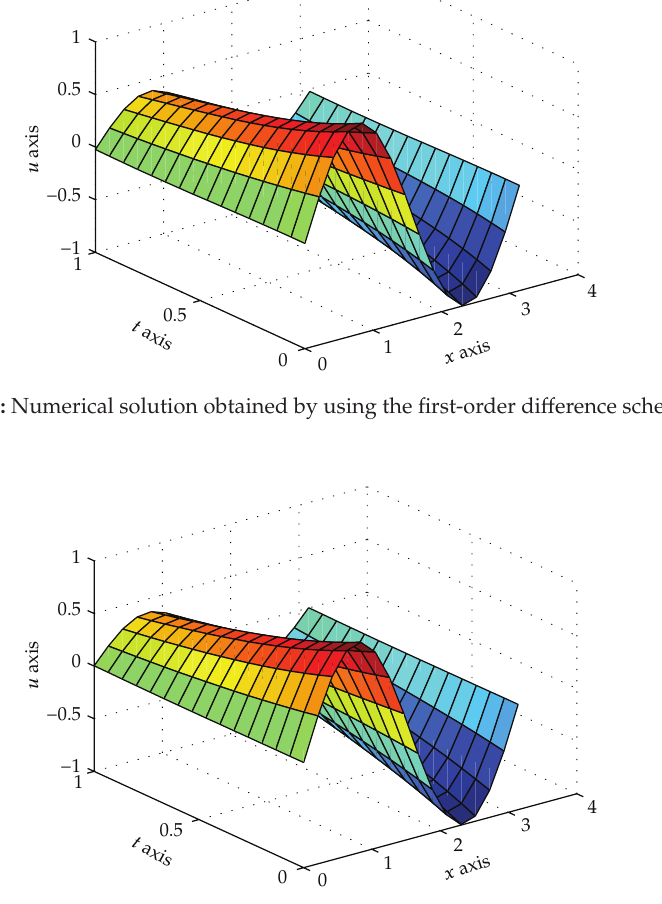
Figure 3: Numerical solution obtained by using the second-order di ff erence scheme (cid:4) 2.7 (cid:5) .